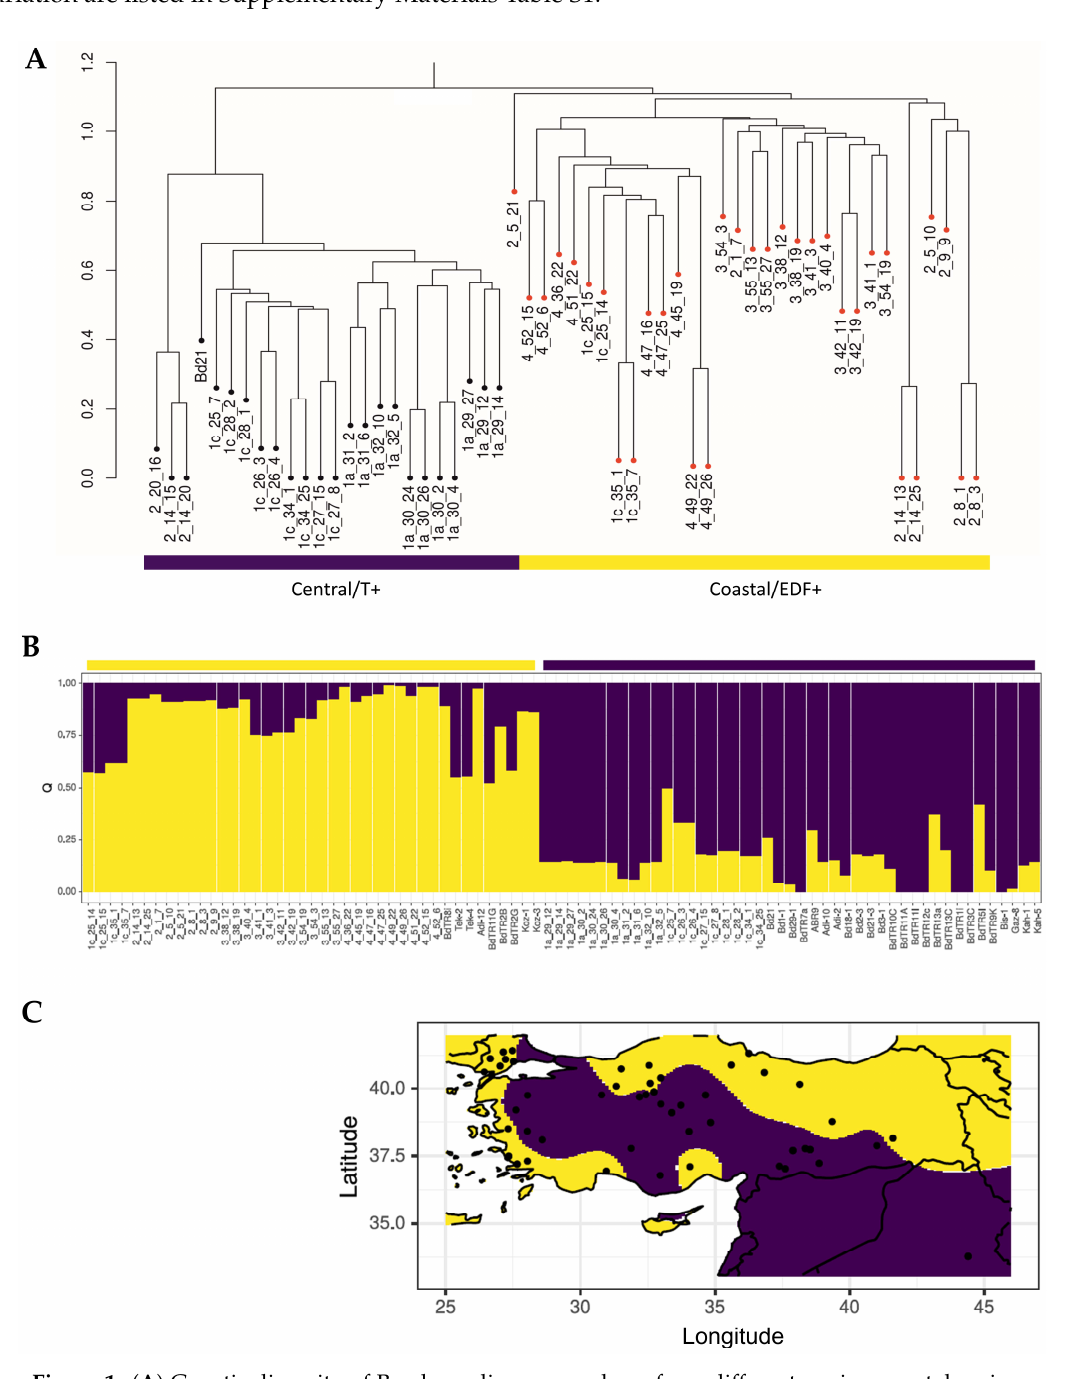
Figure 1. ( A ) Genetic diversity of Brachypodium germplasm from different environmental regions of Turkey as indicated using hierarchical clustering. ( B ) Ancestry coefficients were estimated with TESS3 two ancestral groups amongst Brachypodium accessions (listed in Supplementary Materials Table S1) and ( C ) mapped to Turkey by purple and yellow colors. The yellow and purple horizontal regions indicate accessions corresponding to the ancestral groups and geographically distinguishable as coastal and central subpopulations, respectively. The correspondence between the coastal and central subpopulations and the previously defined Extremely Delayed Flowering (EDF + ) and Turkish (T + ) populations [10], respectively, is indicated.